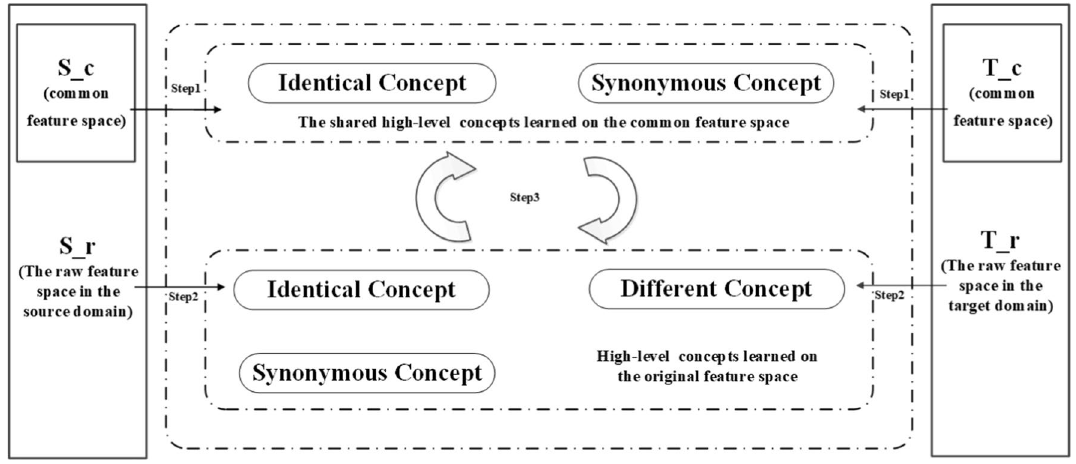
Fig. 2 The framework of DSTL (the white arrows show the transmission of indirect mutual promotion effects between the common feature space and the original feature